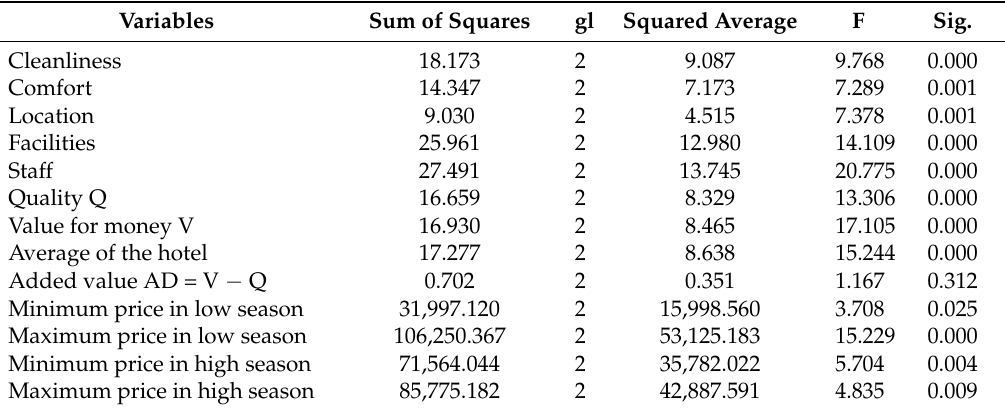
Table 10. ANOVA analysis of the destinations of Gran Canaria, Tenerife y Agadir.